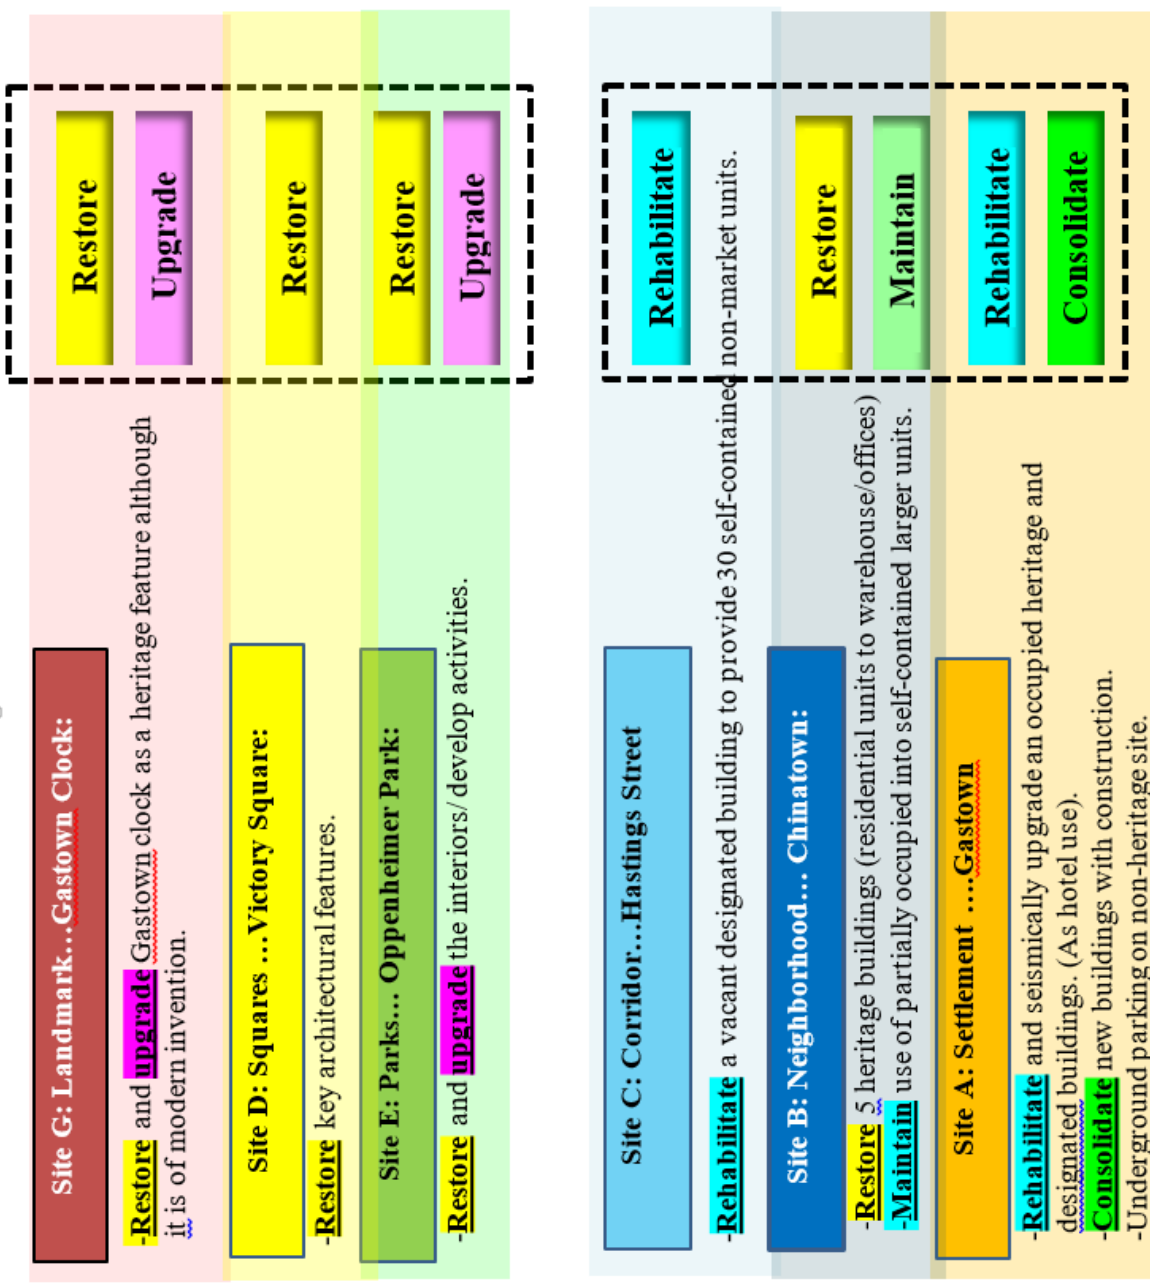
Figure 7. Conclusion. Source: The